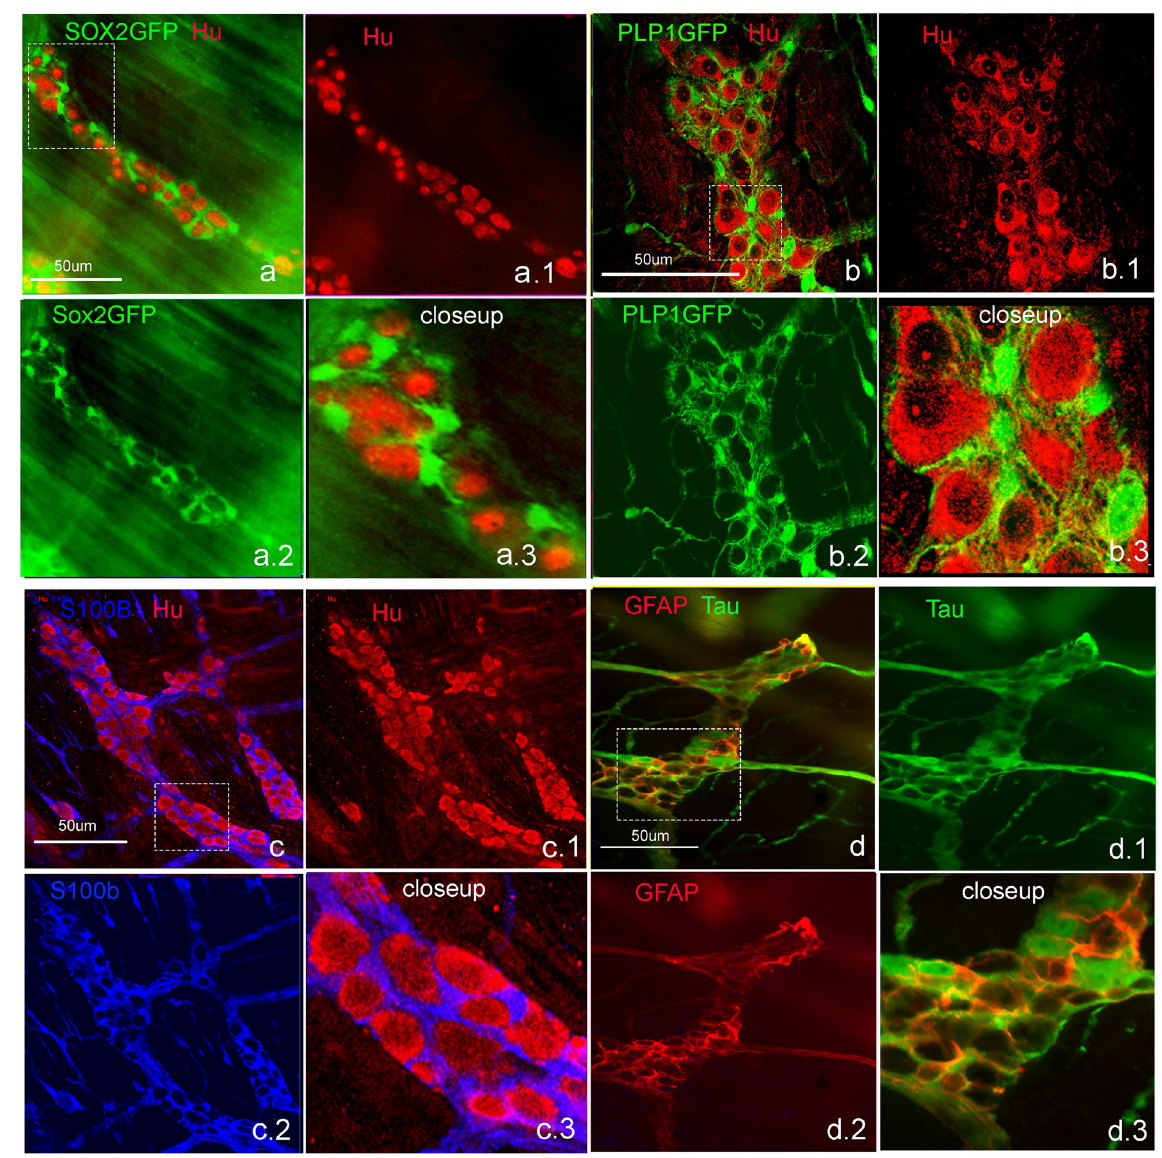
Figure 2. Sox2, PLP1 and S100b label enteric glia. Sox2GFP ( a ) labels most enteric glial cells in the adult mouse colon. Similarly, PLP1GFP ( b ) also labels most enteric glial cells. S100b is a third marker labeling most glial cells ( c ). GFAP, however only labels a fraction of enteric glia ( d , d.3 close up of boxed area in d ). (All Figures were taken at 200x, except closeup